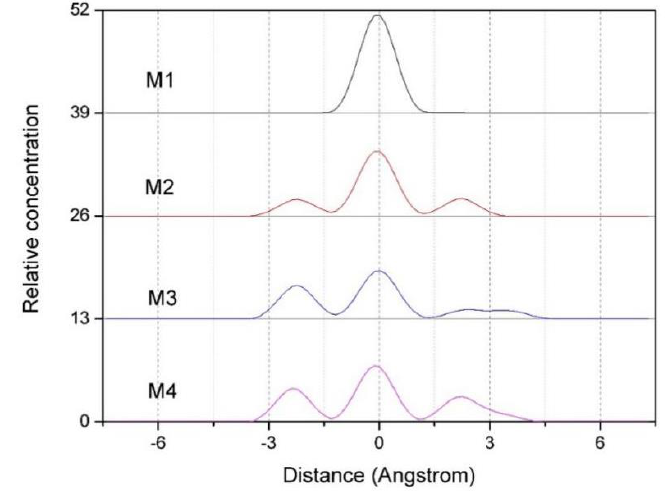
Figure4. TheZ-densityprofilesofCa 2 + intheinterlayerofmontmorillonitewithdi ff Figure 4. The Z-density profiles of Ca 2+ in the interlayer of montmorillonite with different charge density.